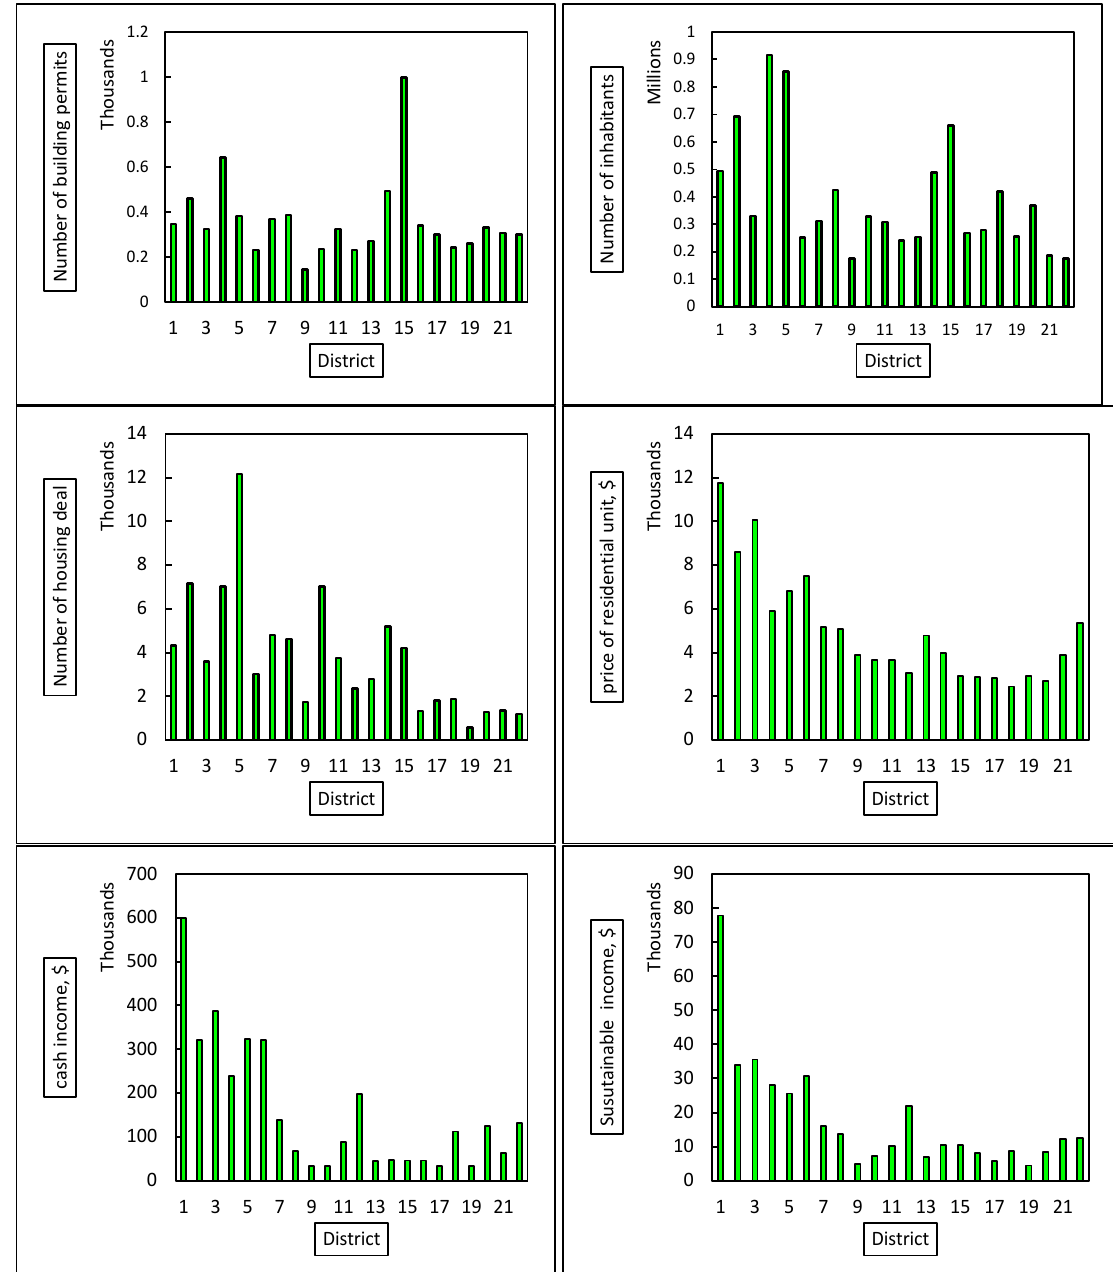
Fig. 3: A graphical representation of BCC-O's input and output